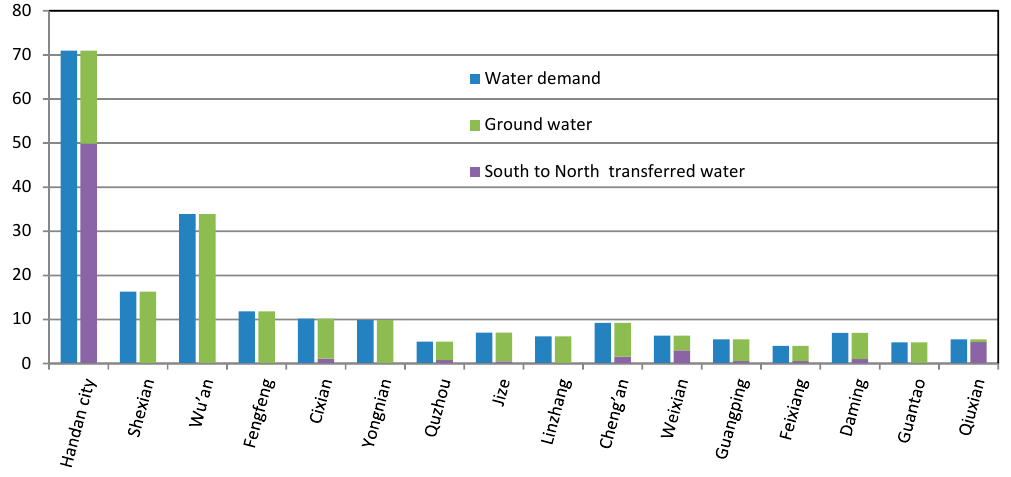
Figure 8. Tertiary sector water allocation in each sub-region in Handan (10 6 m 3 ).